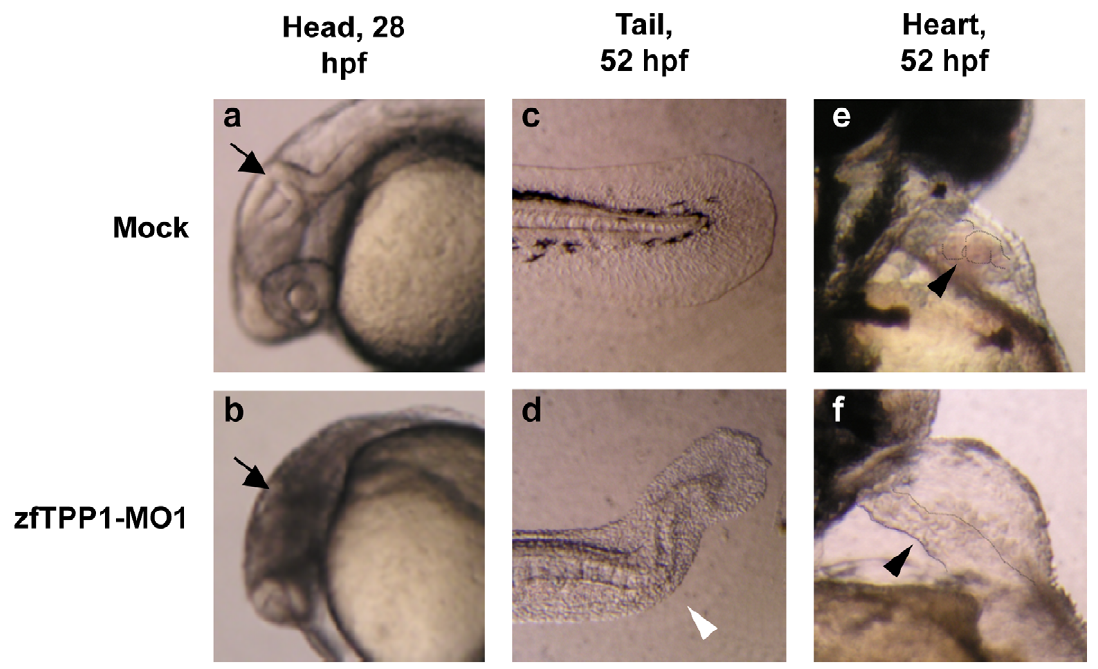
Figure 6. zfTPP1 knockdown results in defects in the brain, tail and heart. Mock (a, c, e) and zfTPP1-MO1 injected embryos (b, d, f) were visualized at the indicated time points. In a and b, arrows point to the brain. In c and d, arrowhead indicates a curly tail. In e and f, arrowheads point to the heart.